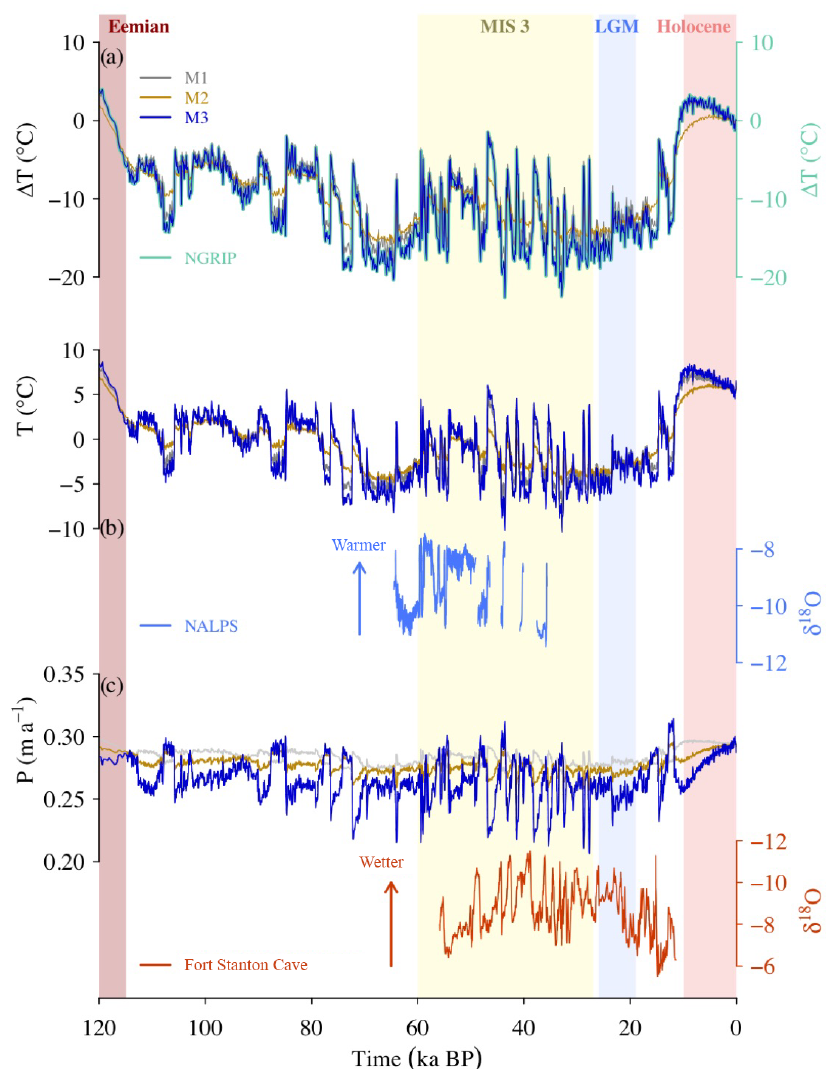
Figure 3. (a) Temporal evolution of SAT anomalies ( ◦ C) at the NGRIP site (75.1 ◦ N, 42.32 ◦ W) relative to the present day obtained in M1 (gray), M2 (gold) and M3 (blue) as compared to the KV (light green) temperature reconstruction (Vinther et al., 2009; Kindler et al., 2014). (b) Temporal evolution of SAT ( ◦ C) in central Europe from the three methods together with δ 18 O (‰ Standard Mean Ocean Water, SMOW) variations inferred from stalagmites of northern European Alps (47.38 ◦ N, 10.15 ◦ E) as a proxy for air temperature (Moseley et